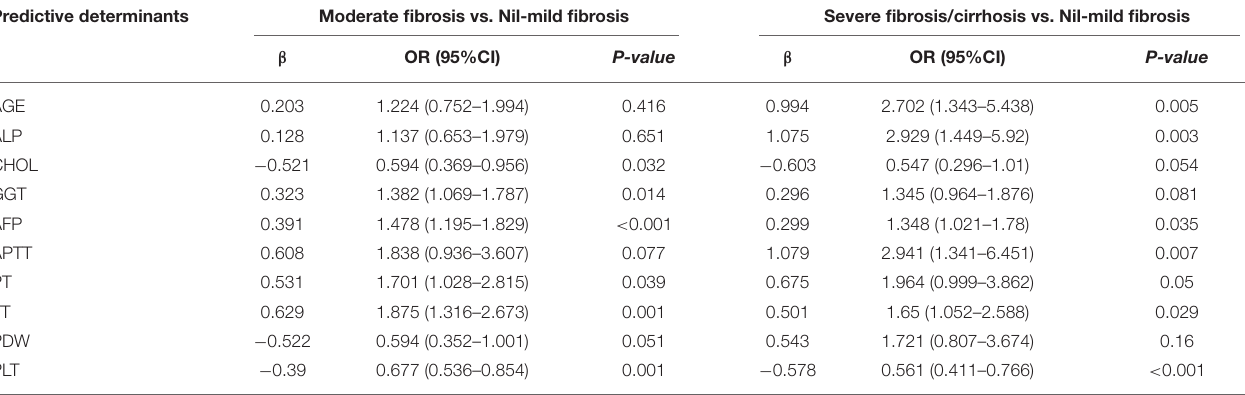
TABLE 3 | Multinomial estimates from the final multinomial logistic regression